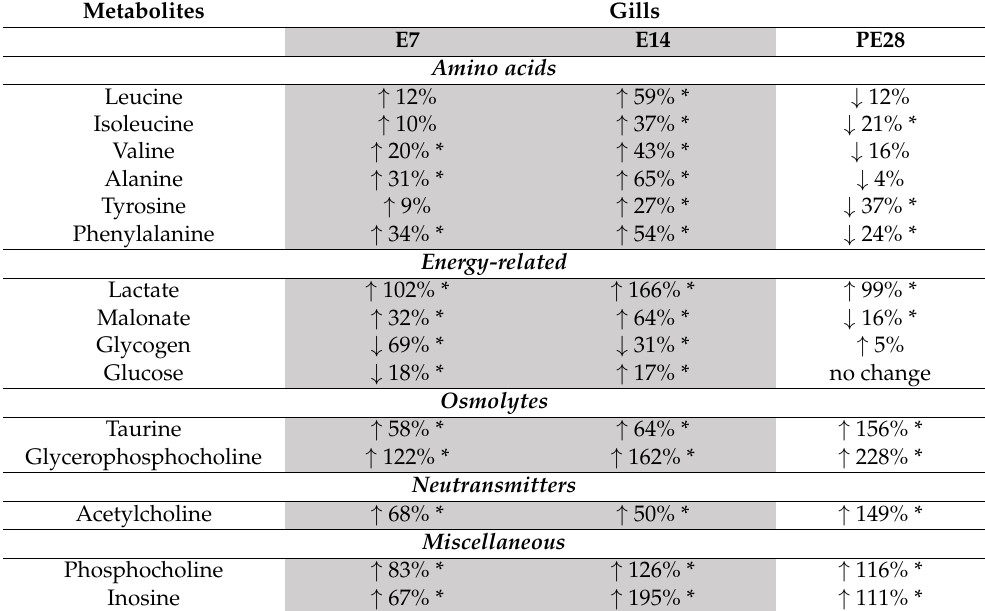
Table 1. Percent changes in concentrations of metabolites in the gills of white seabream ( D. sargus ) following MeHg-dietary exposure (E7, E14) and post-exposure (PE28) periods, in relation to control groups (n = 6) (Dunnett’s test, * p < 0.05; ↑ and ↓ indicate an increase and decrease in respect to the control group,